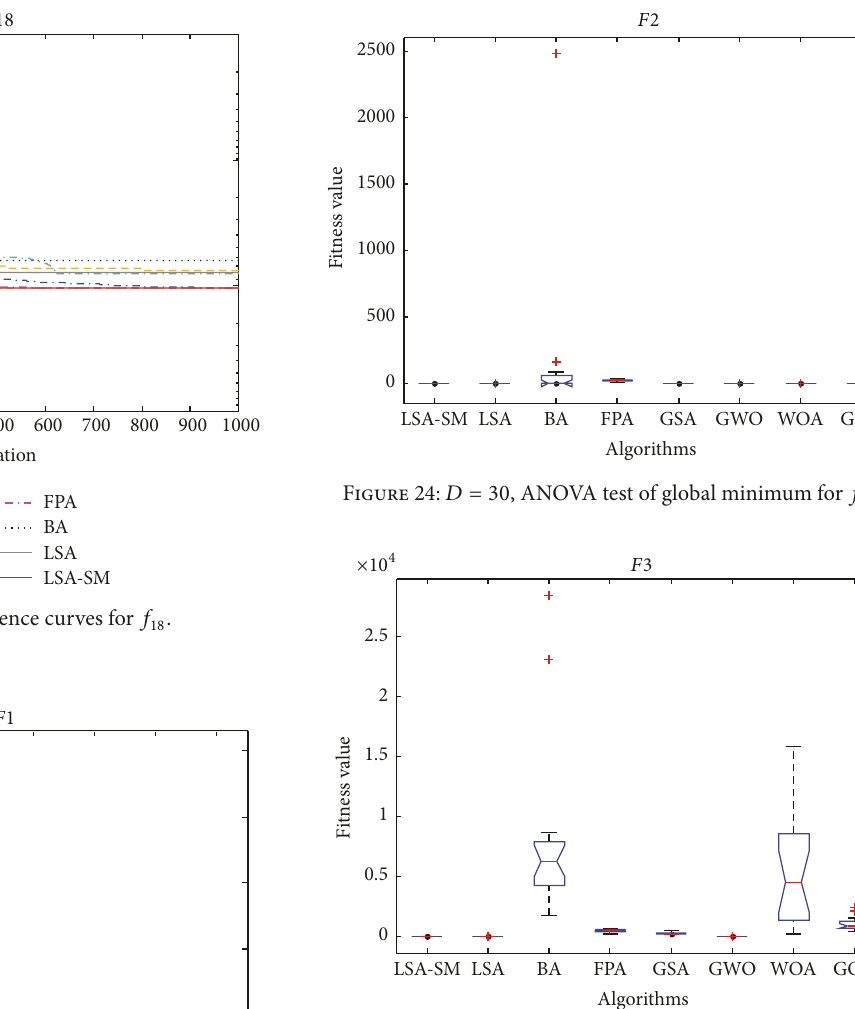
Figure 25: 𝐷 = 30 , ANOVA test of global minimum for 𝑓 03